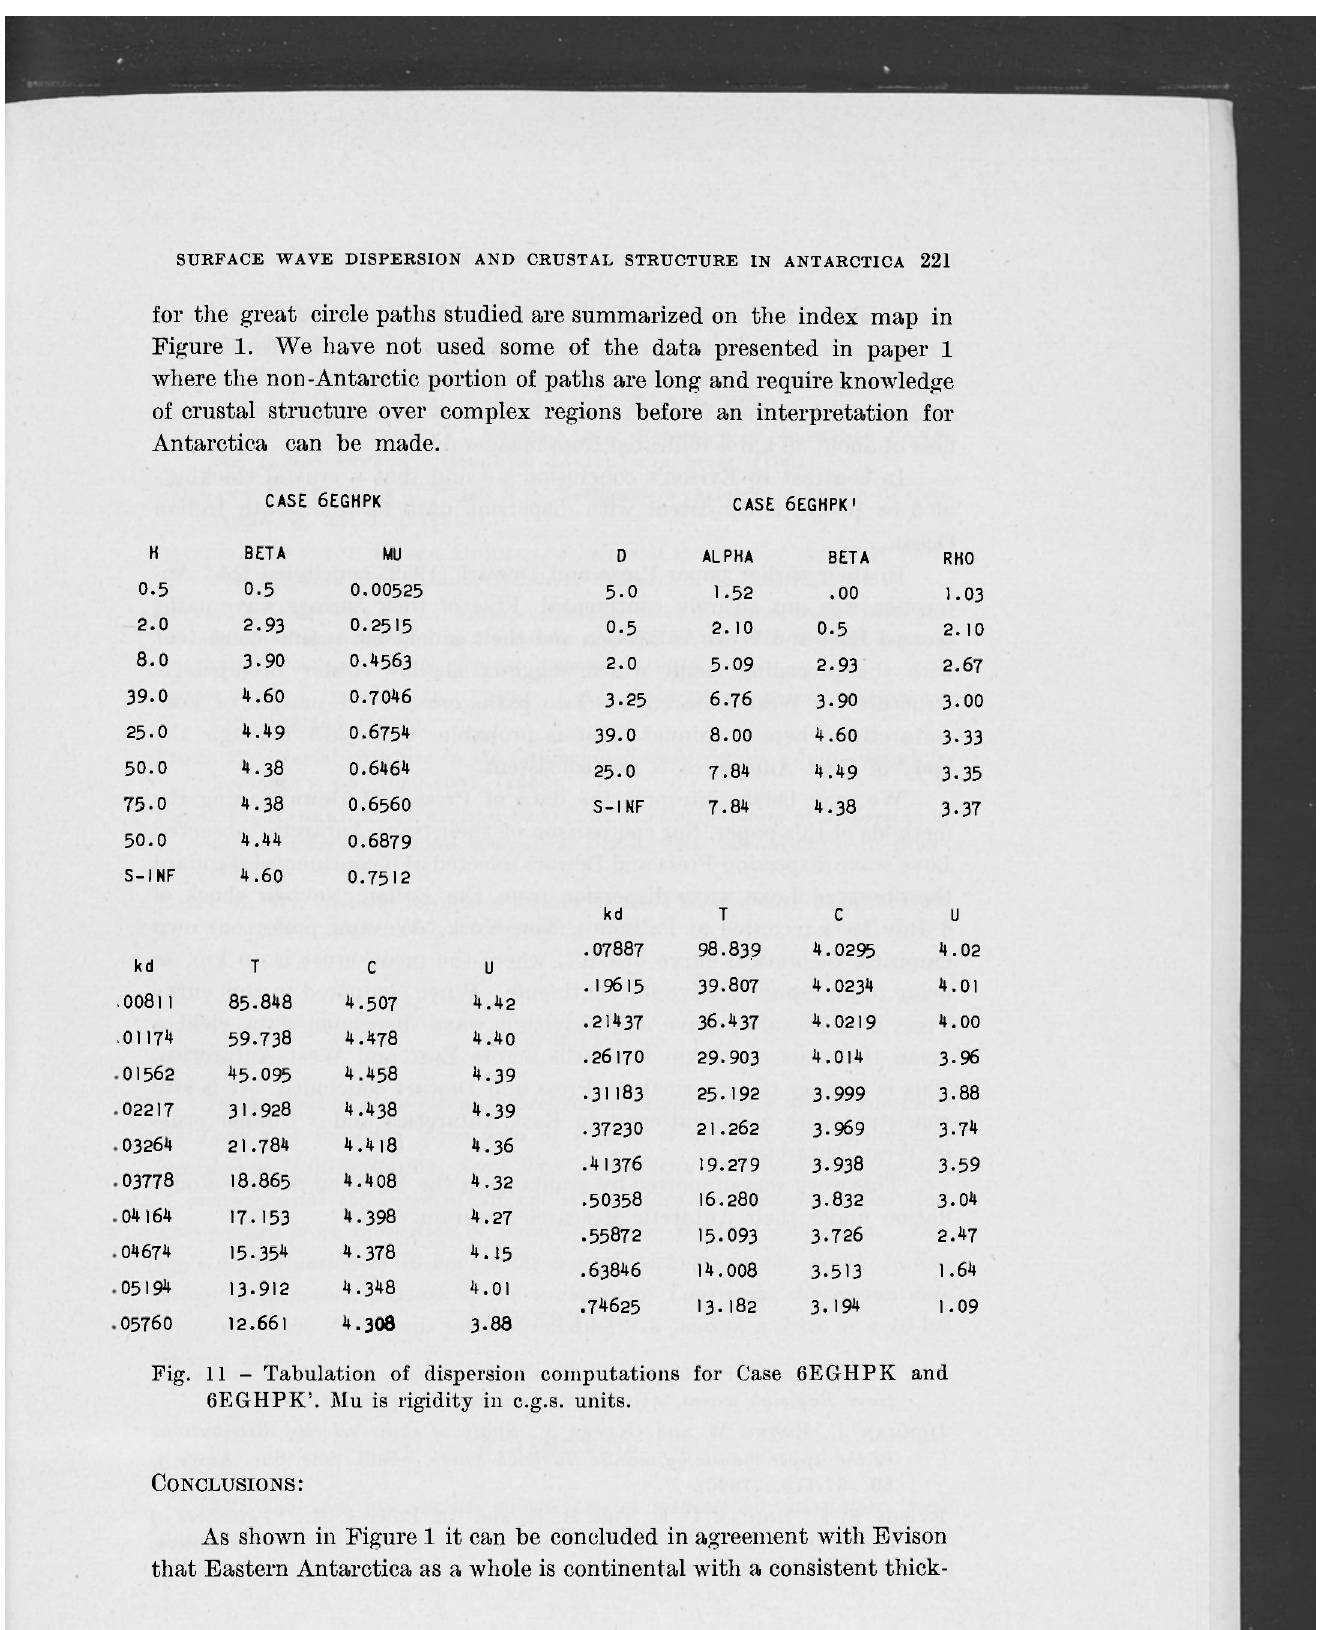
Pig. 1 1 - Tabulation of dispersion computations for Case 6EGHPK and 6EGHPK'. Mu is rigidity in c.g.s.